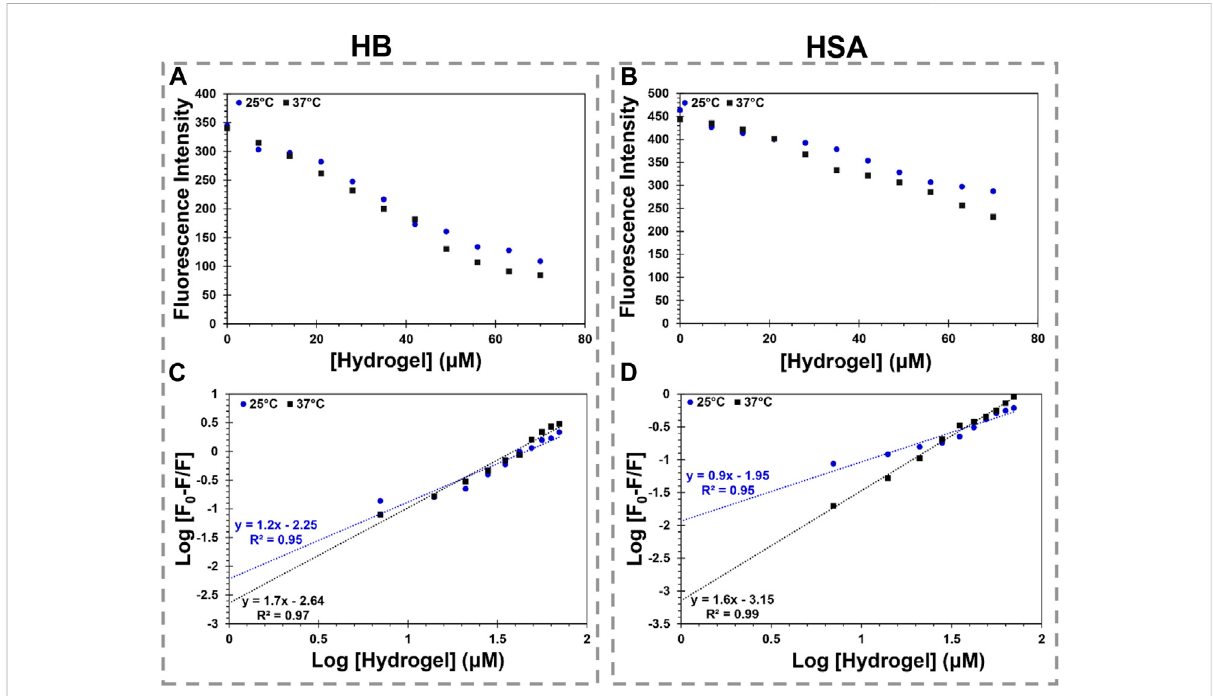
FIGURE 5 MS2 hydrogel interaction with HB and HSA. (A,B) show the changes in maximum fl uorescence intensity of HB and HSA by MS2 hydrogel (0 – 70 µM), respectively. (C,D) show the logarithmic graph of HB and HSA binding to MS2 hydrogel at various temperatures,